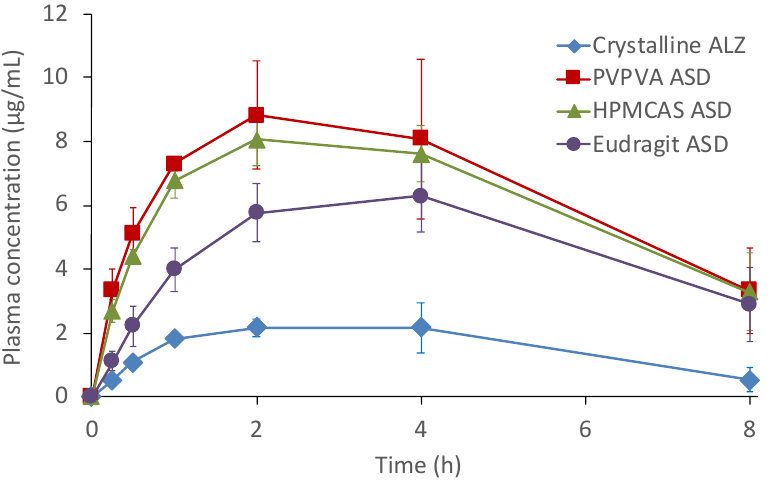
Figure 6. Plasma ALZ sulfoxide concentration profiles after oral administration of crystalline ALZ and its ASDs in rats at a dose of 10 mg/kg ( n = 3). Symbols: Crystalline ALZ ( ◆ ), PVPVA ASD ( ■ ), HPMCAS ASD ( ▲ ), Eudragit ASD ( ● ). Table 3. PK parameters for oral administration study of ALZ ASDs in rats. Formulations